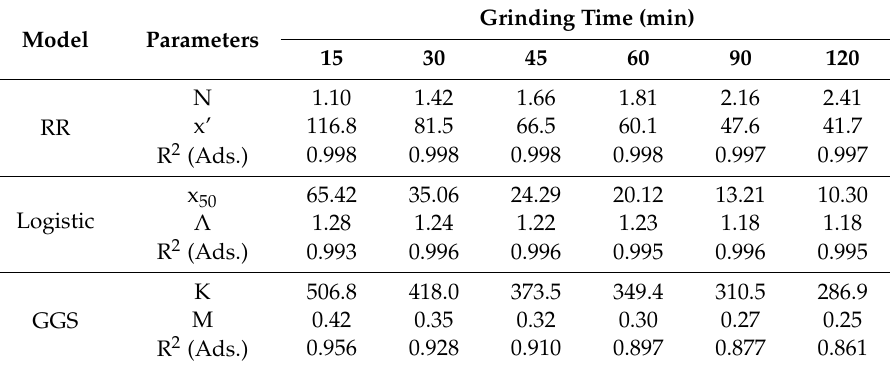
Table 5. Model distribution parameters for the slag grinding products.